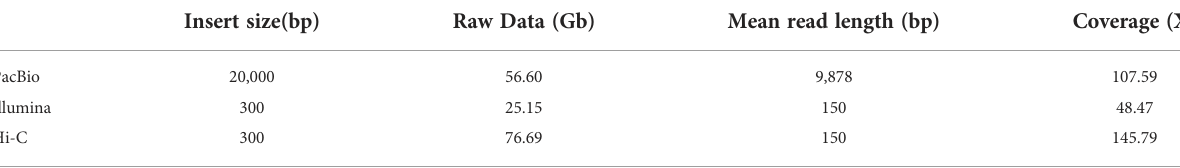
TABLE 1 Summary of sequencing data for Verasper variegatus genome